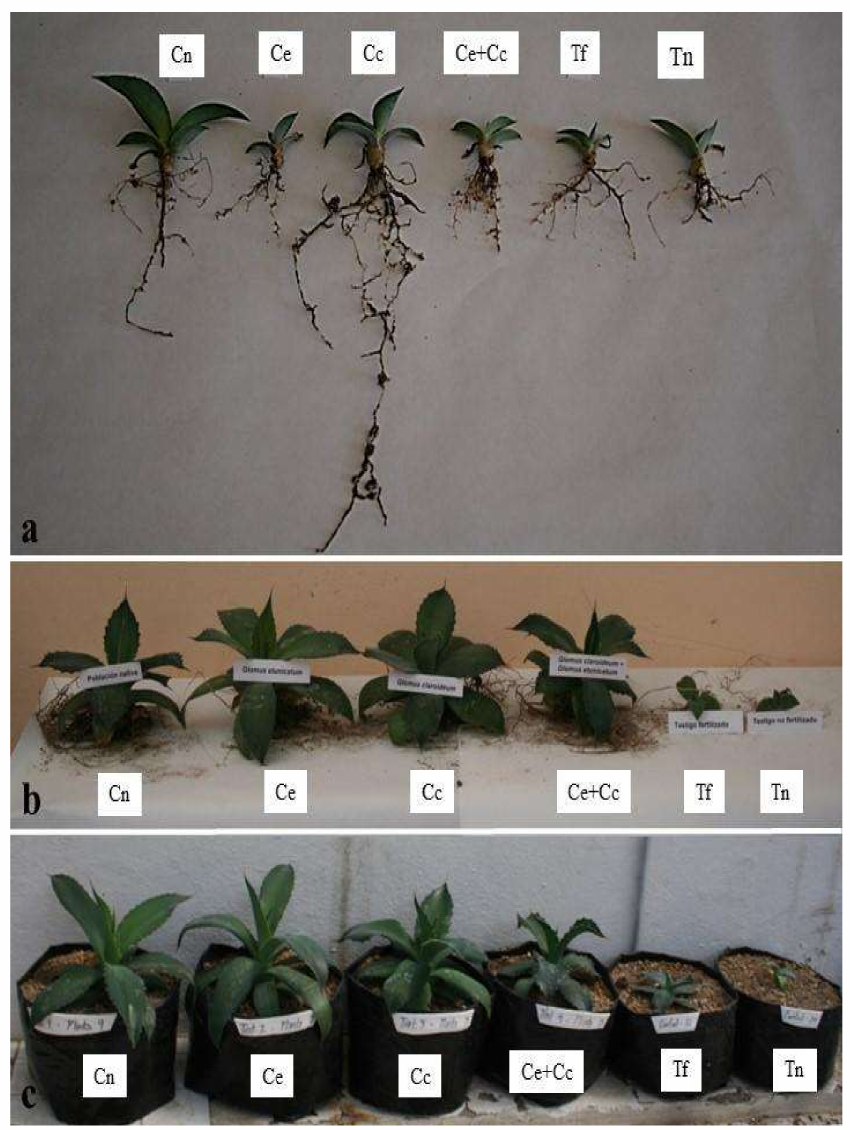
Figure 4. Agave maximiliana plants of four treatments that included inoculation with arbuscular mycorrhizal fungi (AMF) and two control treatments. Treatments: (1) consortium of autochthonous AMF of the A. maximiliana rhizosphere (Cn), (2) Claroideoglomus etunicatum (Ce), (3) Claroideoglomus claroideum (Cc), (4) C. etunicatum + C. claroideum (Ce + Cc), (5) control with fertilization and without mycorrhizal inoculation (Tf), and (6) control without fertilization or mycorrhizal inoculation (Tn). ( a ) Plants at 6 months of treatment. ( b ) Plants at 12 months of treatment. ( c ) Plants at 18 months of